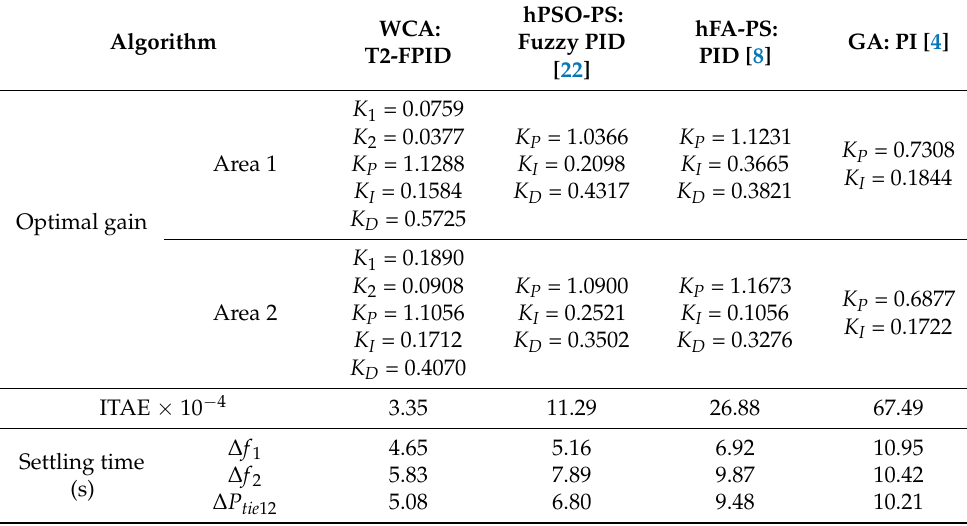
Figure 7. Responses for case 1: ( a ) ∆ f 1 ( b ) ∆ P tie 12 and ( c ) ∆ f 2 . Table 2. Optimal controller gains and settling times of responses for case 1.